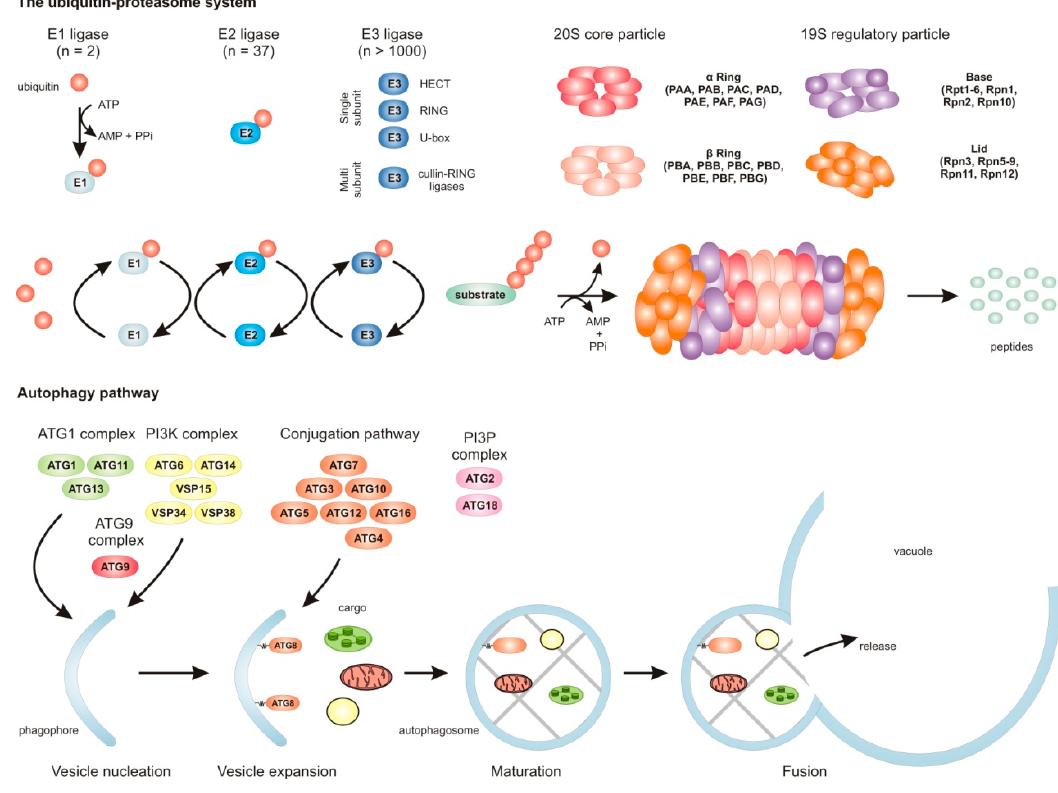
Figure 1. Overview of the main cellular protein clearance mechanisms, the ubiquitin–proteasome system (UPS), and the autophagy pathway. Protein degradation by the UPS is initiated by the specific labeling of target proteins with ubiquitin. Attachment of a ubiquitin molecule requires the action of three enzymes, an ATP-dependent ubiquitin-activating enzyme (E1), a subsequent ubiquitin-conjugating enzyme (E2), and finally a ubiquitin ligase (E3) that transfers the ubiquitin from E2 to a target protein. After (poly)ubiquitination, the target protein is recognized and degraded by the 26S proteasome. Proteasomes contain a 19S regulatory particle and a catalytic active core particle (20S). The 19S regulatory particle recognizes the substrates, deubiquitinates the substrates, and unfolds them at the expense of ATP. The unfolded protein is translocated into the active chamber of the 20S particle to be degraded by the different proteases. The lower part of the figure represents the autophagy pathway. Autophagosomes are initiated by the formation of a phagophore at the outer surface of the ER through the action of the ATG1 complex, ATG9, and the PI3K complex. The growing phagophore surrounds cellular targets in either a selective or nonselective manner. Especially ATG8 plays a major role in substrate recognition for both the selective and nonselective pathways. A mature autophagosome moves toward the vacuole and fuses with it to release its cargo for proteolytic processing.